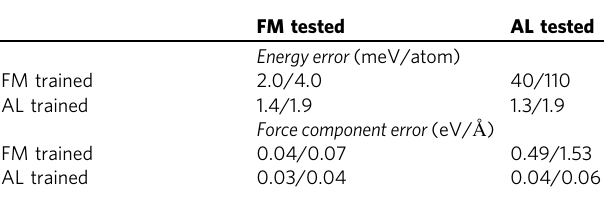
Table 1 Mean absolute and root-mean squared errors (MAE/RMSE) of ANI-Al models trained/tested on combinations of FCC/Melt (FM) and active learning (AL)